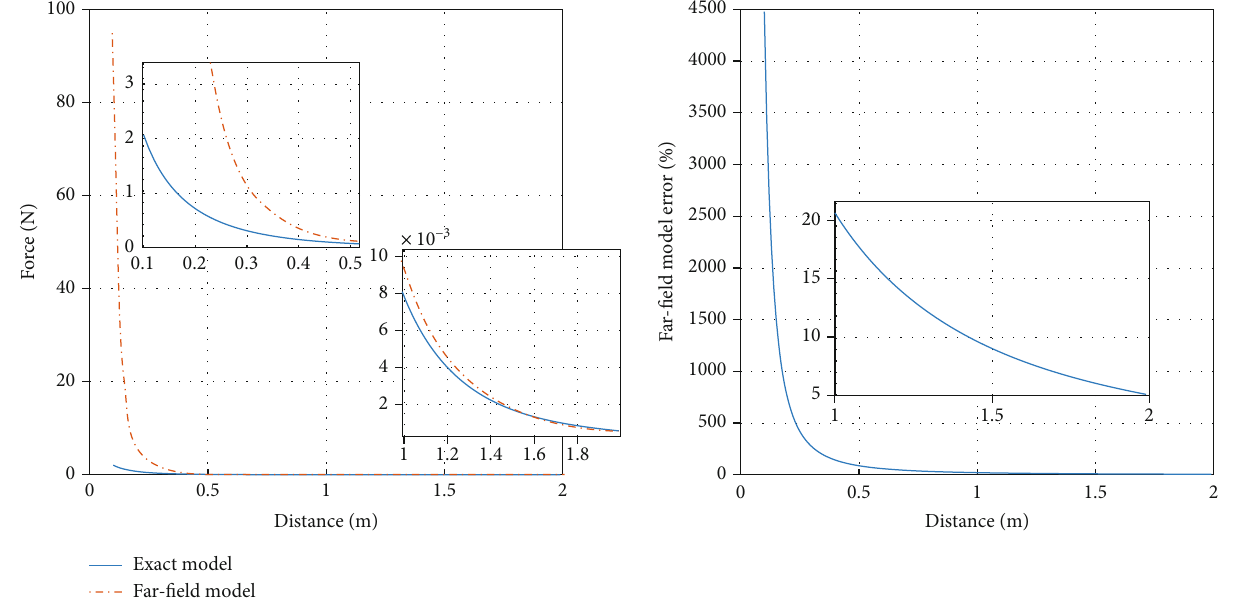
Figure 4: Calculation results and percent error of the far- fi eld